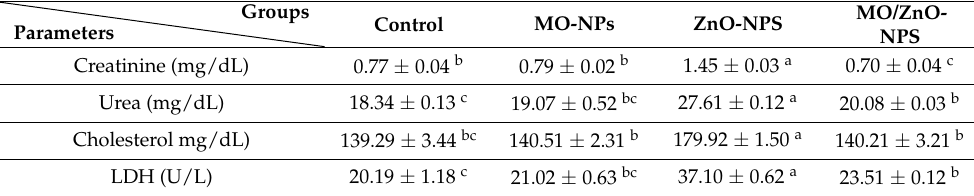
Means with different superscript letters in the same row for each parameter are significantly different ( p < 0.05). Means bearing with different subscript are significantly different ( p < 0.05) as analyzed by one-way ANOVA, MO-